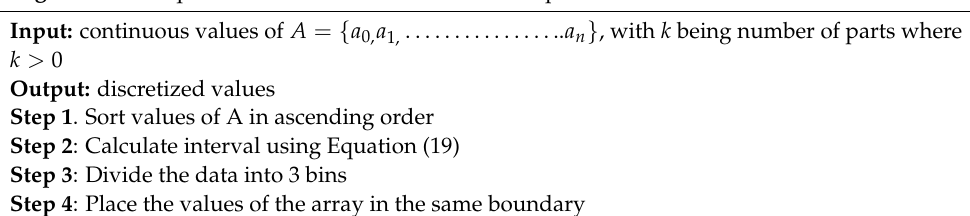
Algorithms 1: Equal-Width Interval Discretization